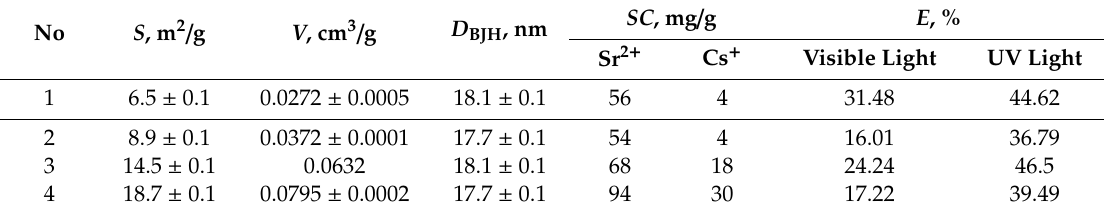
Table 4. Surface, sorption and photochemical characteristics of titanosilicate products.